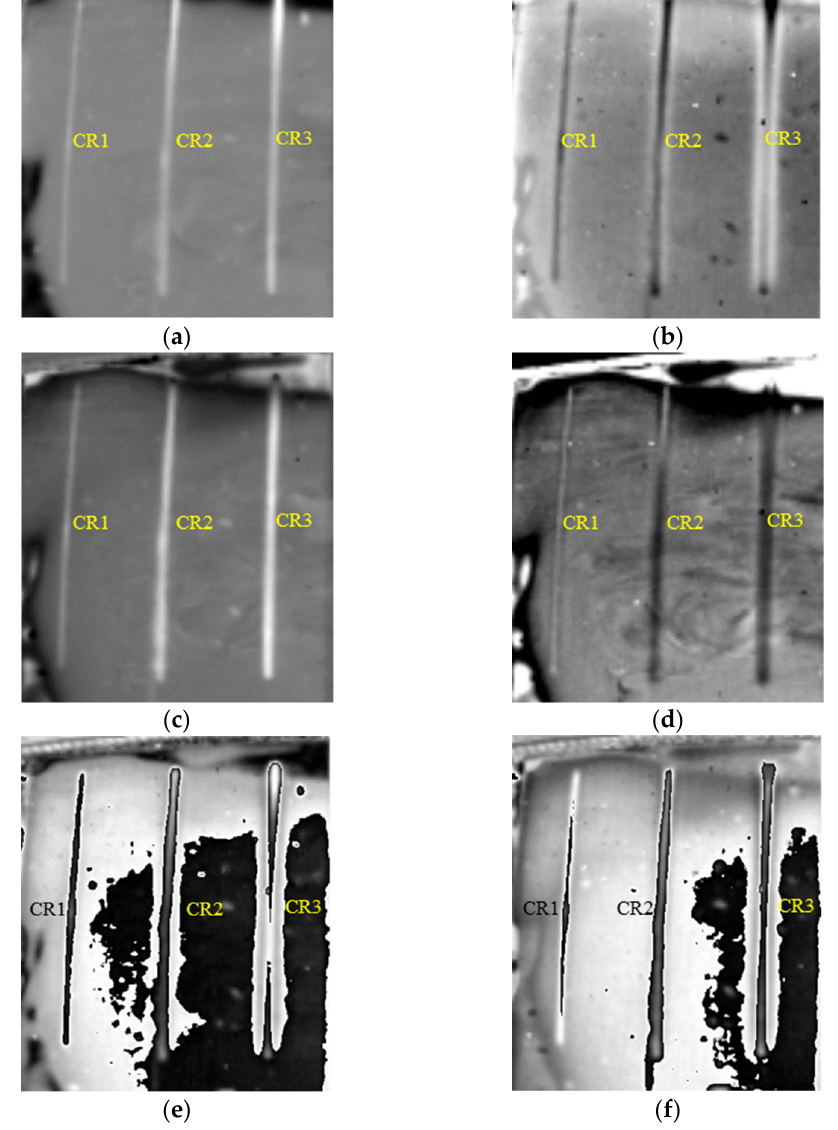
Figure 9. Detection results of cracks in FRP bonded with 1 mm thick SIR. ( a ) The 628th frame 1st DTI. ( b ) The 819th frame 1st DTI. ( c ) The 589th frame 2nd DTI. ( d ) The 829th frame 2nd DTI. ( e ) FDTI from subtracting 1st DTIs. ( f ) FDTI from subtracting 2nd DTIs.